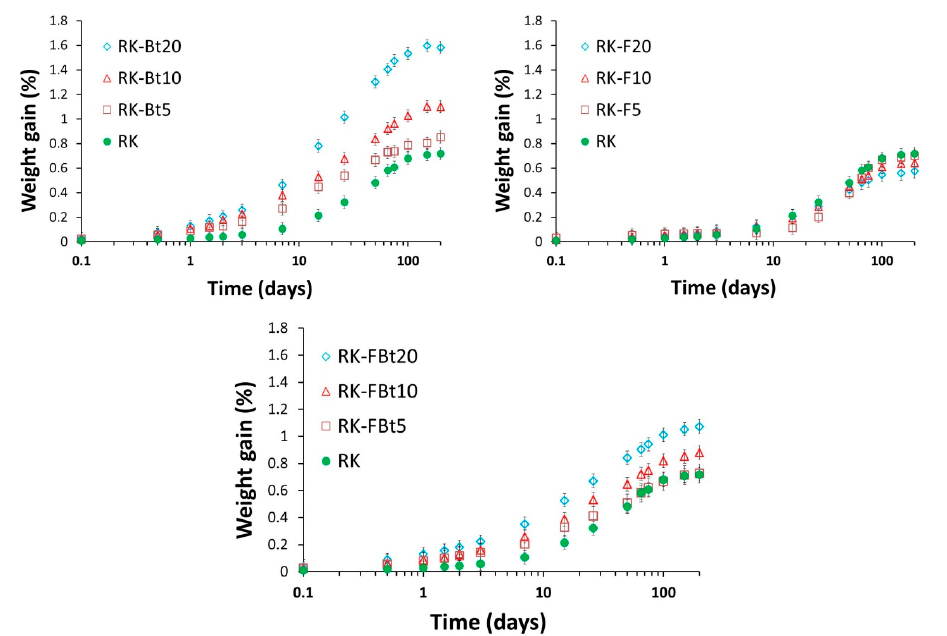
Figure 3. Weight gain as function of conditioning time in water at 37 °C for neat RK resin and all hybrid composites. Polymers 2019 , 11 , x FOR PEER REVIEW